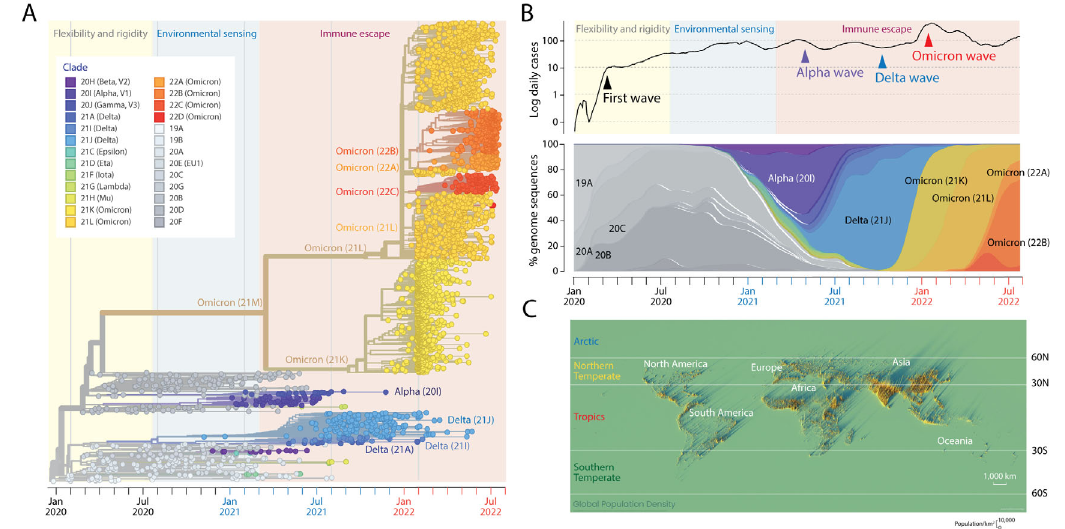
Figure 1. The mutational landscape of SARS-CoV-2 at the end of July 2022 and the spread of variants throughout the world during the pandemic. (A). A maximum likelihood phylogenetic tree describing the world- wide history of the SARS-CoV-2 genome. The timetree of 2,906 genomes randomly sampled between December 2019andJuly29,2022wasobtainedfromNextstrain.Thetreeunfoldsthetimeofgenomecollectiondatefromleftto right. Its leaves (taxa indicated with circles) are colored according to the clade (group of taxa with a common evolutionaryorigin)andemerging variantsofconcern (VOCs)nomenclature.TheoriginofVOCs occurswhen aclade originatesalongbranchesofthephylogeny.NotetheearlyarrivalofVOCAlpha,followedbyVOCDeltaandthenVOC Omicron. The timeline of clades and VOCs shows three successive phases driven by proteome flexibility and rigidity, environmental sensing, and vaccine-driven immune escape, which are shaded in light yellow, blue, and salmon, respectively (Caetano-Anollés et al. , 2022). (B). Plots showing the number of daily newly confirmed cases per million people (on a logarithmic scale and as 7-day rolling averages) and smooth percentages of genomes holding major VOCs since the beginning of the recorded COVID-19 pandemic. COVID-19 and genome data were retrieved from Johns Hopkins Univ., CSSE and GISAID, respectively. (C). Spike map showing a 3-dimensional representation of the populationdensityoftheworldasagridofverticalbarsdepictingthenumberofpeoplepersquarekilometerofland area. Each spike represents the population in a grid of 2 km × 2 km. Light and shadow effects on the map highlight areas of high population density but also isolated population centers. Note the map shows no land. Instead it highlightslocationswhere the7.8billionpeopleof theworld live(as of2020). Labeled latitudes wereused tosplit the world into four regions: Arctic, Northern Temperate, Tropics, and Southern Temperate, which are identified with coloredletterings on the map and used todivide the genomic pool of the virus. The spike map is courtesy of Alasdair Rae, Automatic Knowledge Ltd., Sheffield, UK, reproduced with